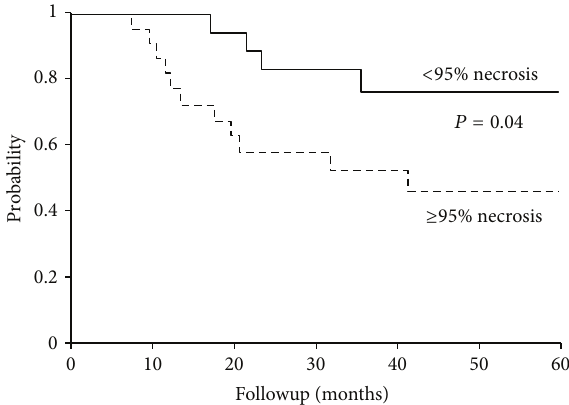
Figure 3: 5-year event-free survival (EFS) by histopathologic response to chemotherapy ( 𝑛 = 43